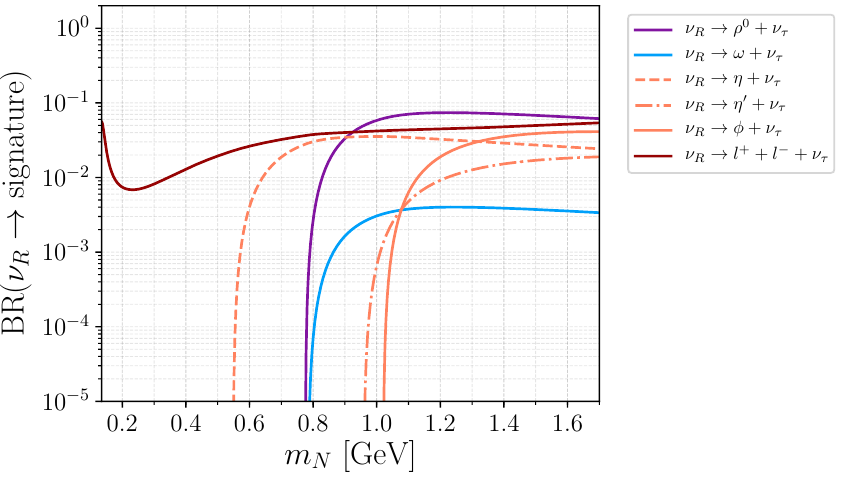
Figure 2 . Branching ratios of visible decay modes in the minimal